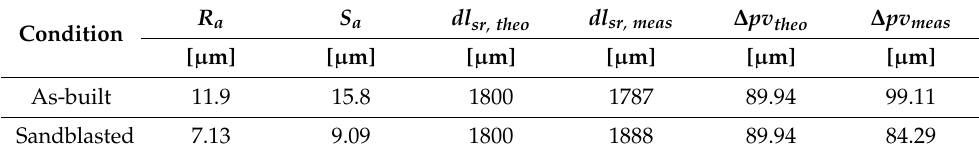
Table 5. Roughness and primary profiles measures for as built and sandblasted